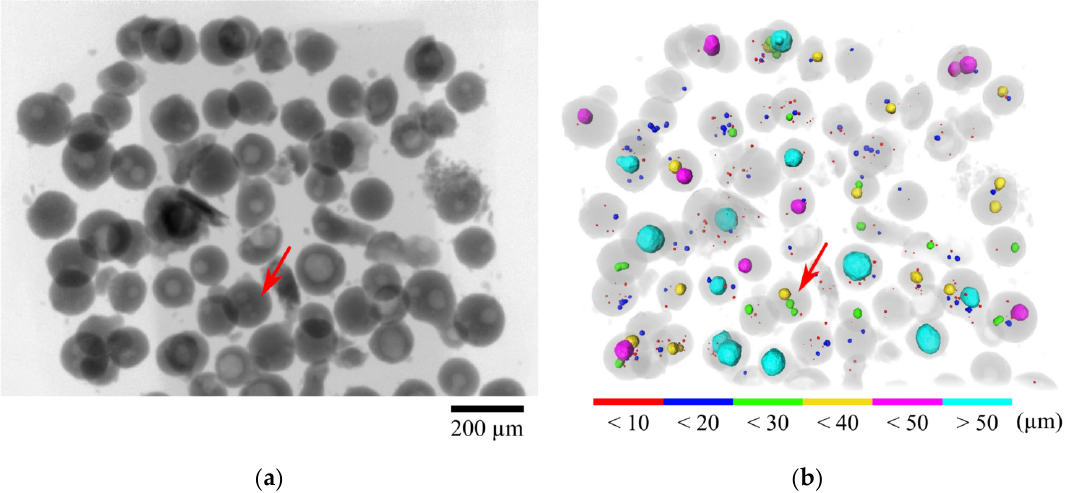
Figure 9. Experimental verification of the simulation results. A monolayer-like multi-particle sample with diameters in between 100 µm and 150 µm and severe porosity inside was prepared and analyzed: ( a ) radiography and ( b ) rendering of the tomogram. A single particle from this monolayer-like sample was picked (red arrows) and was investigated in more detail (see Figure 10).